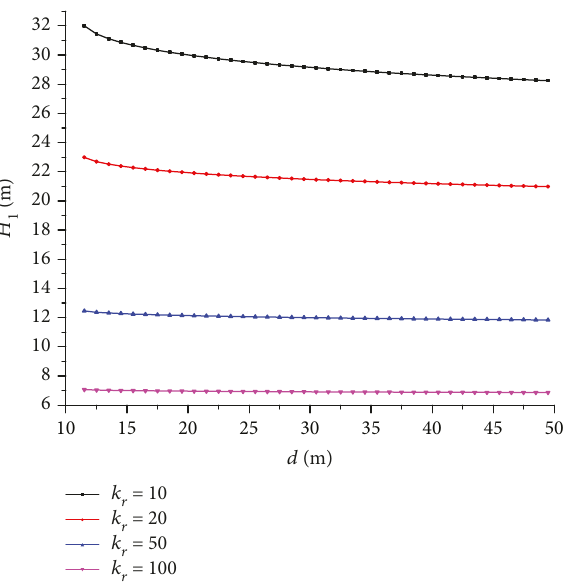
Figure 7: Comparison of numerical solution and theoretical solution for r = 7 25 and r w = 4 .